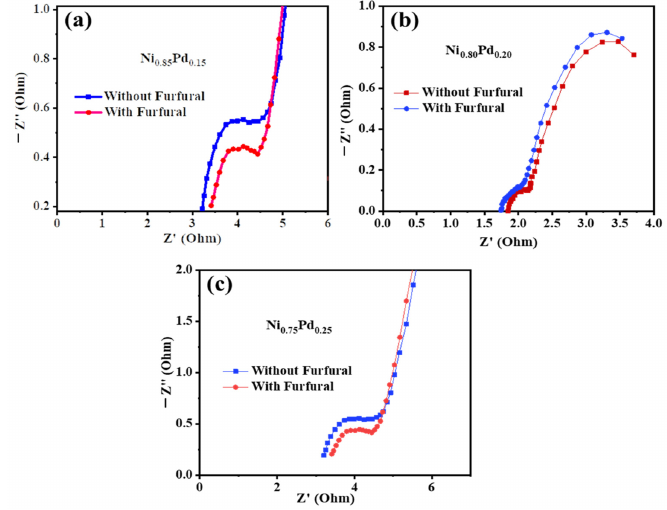
Figure 5. EIS analysis of Ni 0.85 Pd 0.15 (a), Ni 0.80 Pd 0.20 (b), and Ni 0.75 Pd 0.25 (c) with and without furfural.